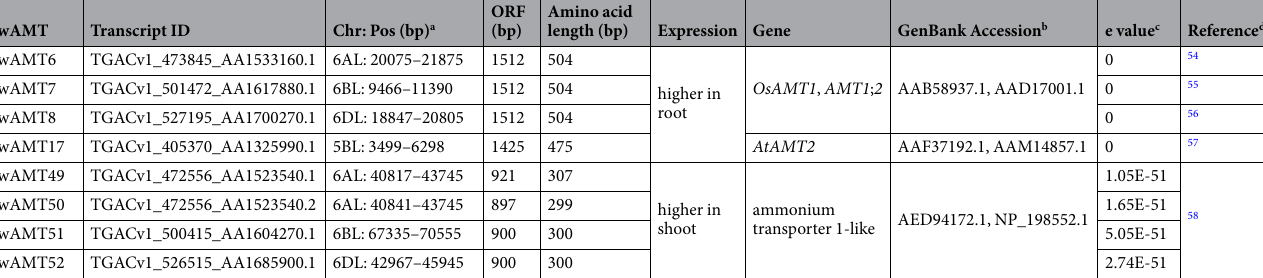
TGACv1_405370_AA1325990.1 5BL: 3499–6298 1425 475